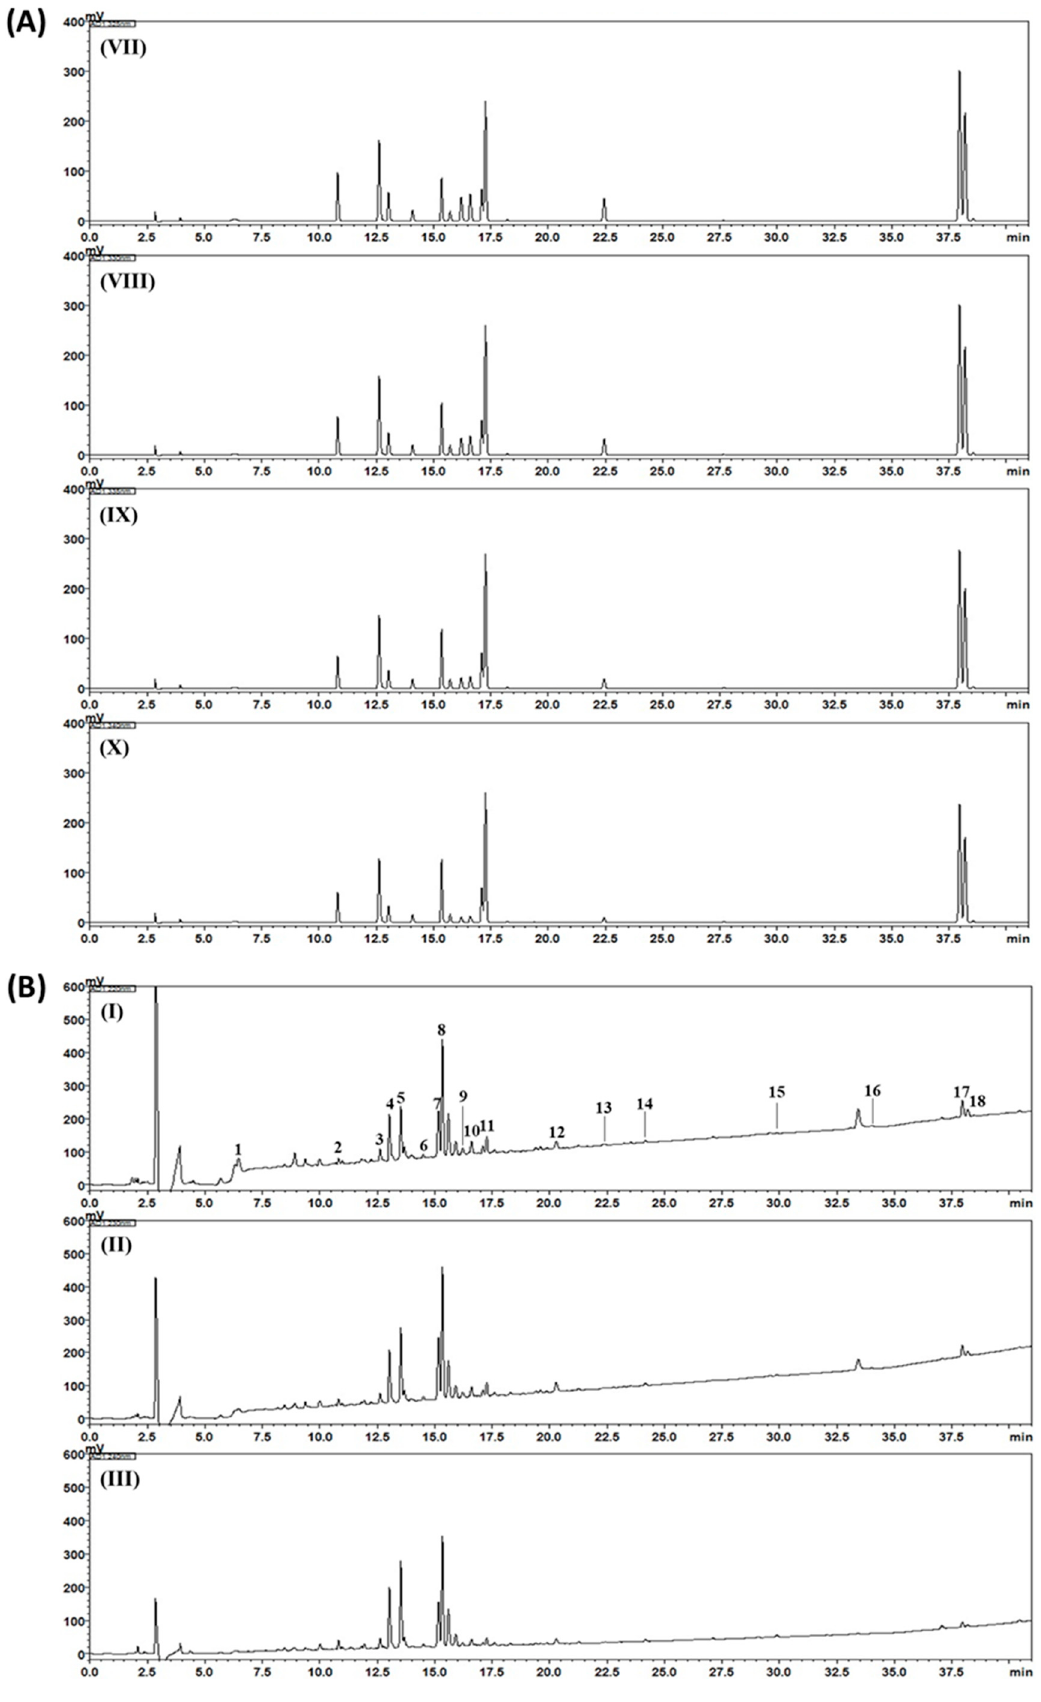
Figure 2. Continued. Figure 2.